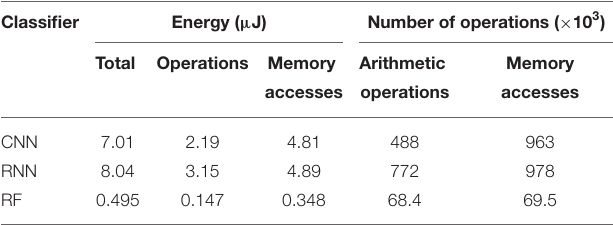
TABLE 6 | Estimated energies, number of arithmetic operations, and memory accesses for the CNN, RNN, and RF classifier. Classifier Energy ( µ J) Number of operations ( × 10 3